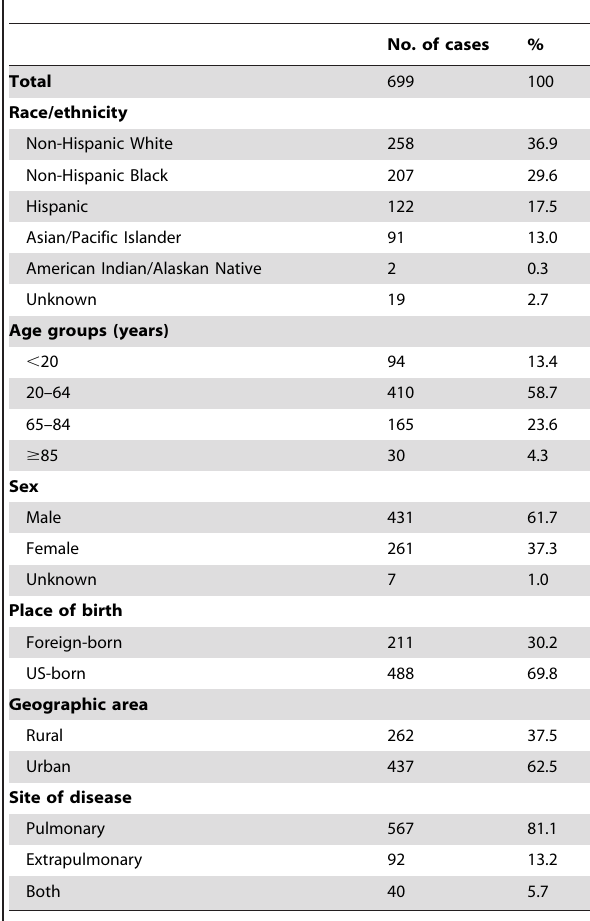
Table 1. Distribution of Demographic Characteristics, Risk Factors, and Clinical Characteristics Among All Tuberculosis Cases Reported in Arkansas During